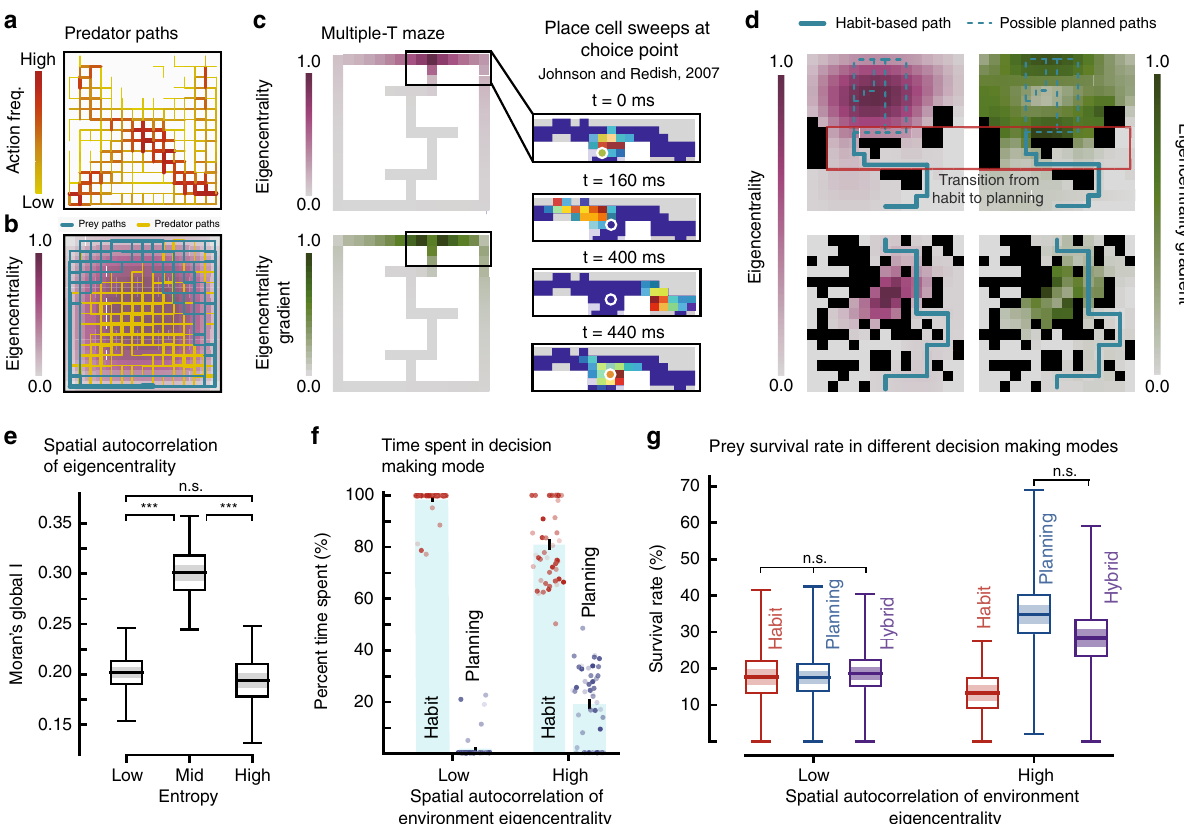
Fig. 4 Using spatial connectivity to arbitrate between behavioral controllers. a Heatmap of all predator paths that resulted in prey capture. Color bar: 1 – 87. b Eigencentrality of an open environment overlaid with representative prey success paths in teal, and prey capture (see ( a )) in orange. Line thickness proportional to action frequency. c Multiple-T maze overlaid with eigencentrality and eigencentrality gradient. Color density proportional to the eigencentrality and eigencentrality gradient of each cell of the quantized maze. Johnson and Redish 34 showed that the neural representation of place (reconstruction on the right) moved ahead of the animal while it paused at the choice point. d Example environments (top row entropy = 0.5, bottom row entropy = 0.9) and their eigencentralities and eigencentrality gradients (see Supplementary Fig. 9 for prey success paths). Transition regions (red box) from low to high eigencentrality and behavioral control based on change in gradient and value of eigencentrality (see Supplementary Fig. 10 for other transition region examples). e Mean spatial autocorrelation (global Moran's I) of the environment eigencentrality. Horizontal line: mean; Shaded region: ±s.e.m; Box: 95% con fi dence interval of the mean; Vertical line: range of the data. For all entropy levels n = 20. MWU tests (two-tailed) across entropy groupings (with Bonferroni correction): U low,mid = 15.0, U mid,high = 13.0, and U low,high = 178.0, (*** p < 10 − 6 ; n.s. is not signi fi cant p = 0.28). f Average percent time spent in decision making regime (habit vs planning) when environments are grouped based on their spatial autocorrelation of eigencentrality ( n low = 50: bottom 25%, n high = 46: top 75%). The error bars indicate ±s.e.m of percent time spent. g Survival rate for a prey that uses planning (blue), habit (red), and hybrid control (purple) based on environment eigencentrality (see ( d ); see Methods). Environment grouping as in ( f ) ( n low = 50, and n high = 46), and representation as in ( e ). Two-tailed KW test for survival rate in environments with low eigencentraliy clustering H = 0.952, p = 0.62. Two-tailed MWU test with Bonferroni correction for survival rate under hybrid and plan-based action selection in environments with high eigencentrality clustering U = 820.5, p = 0.09. Source data are provided as a Source Data fi